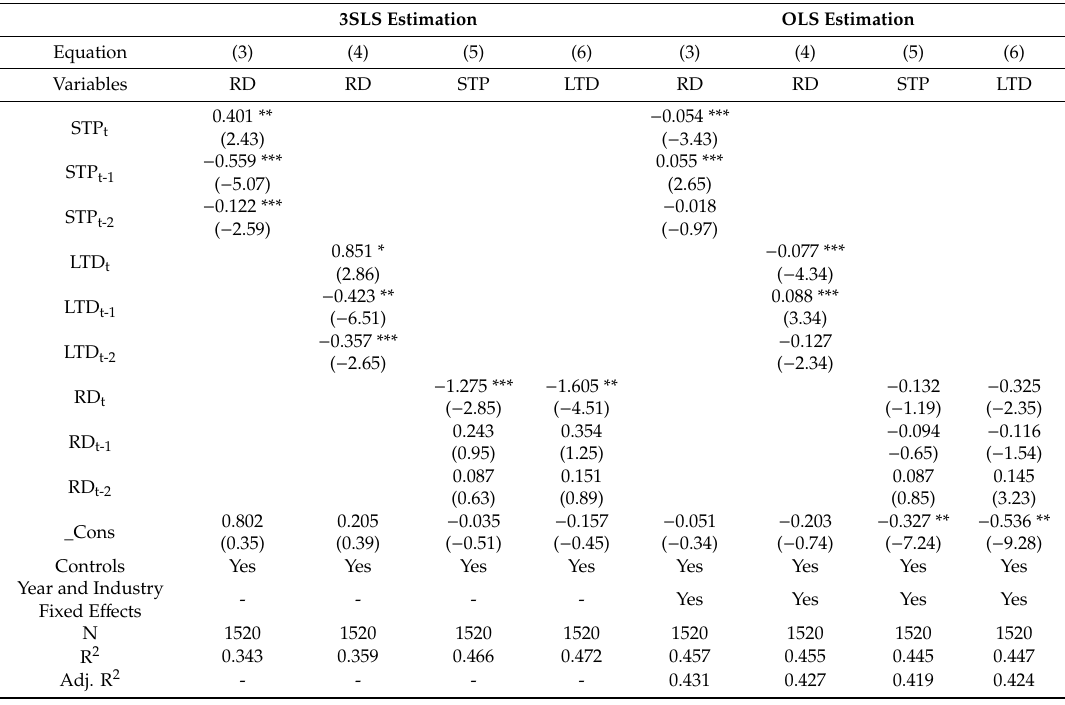
Table 6. The results of three-stage least square (3SLS) and ordinary least square (OLS) regression based on the full